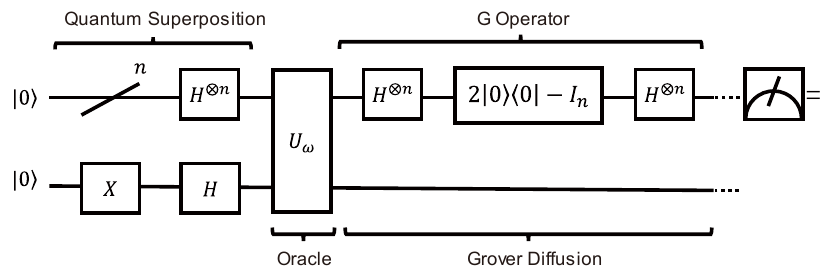
Figure 1. Grover search algorithm quantum circuit framework diagram.